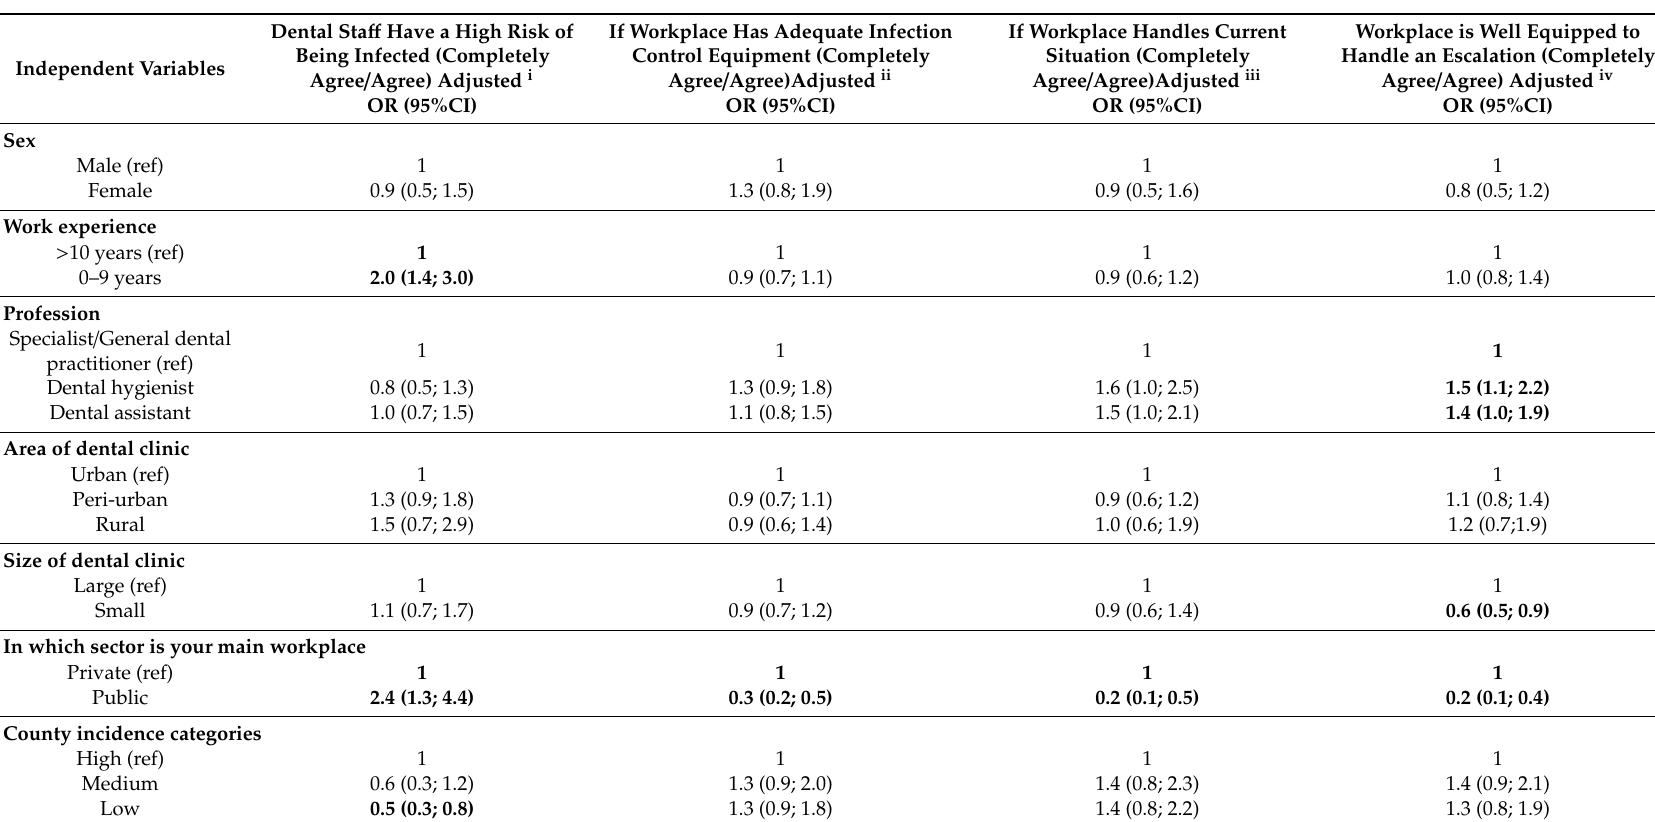
Table 4. Multivariable regression analyses on associations between dental sta ff perception of risk and preparedness, and selected independent variables.